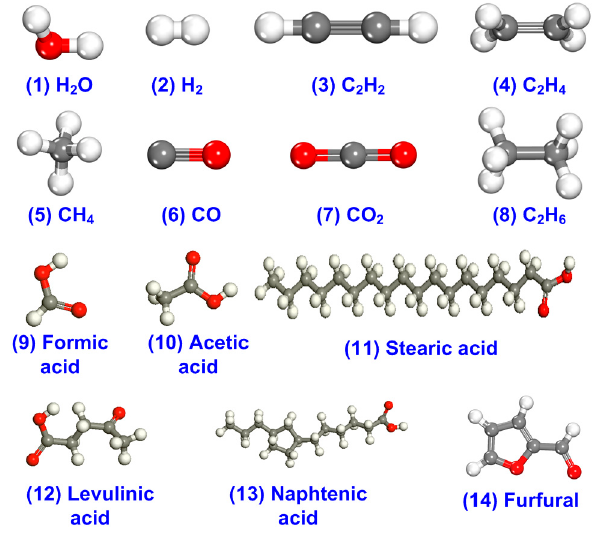
Figure 4. The water, gases, acids, etc. dissolved in mineral insulating oil of transformer.